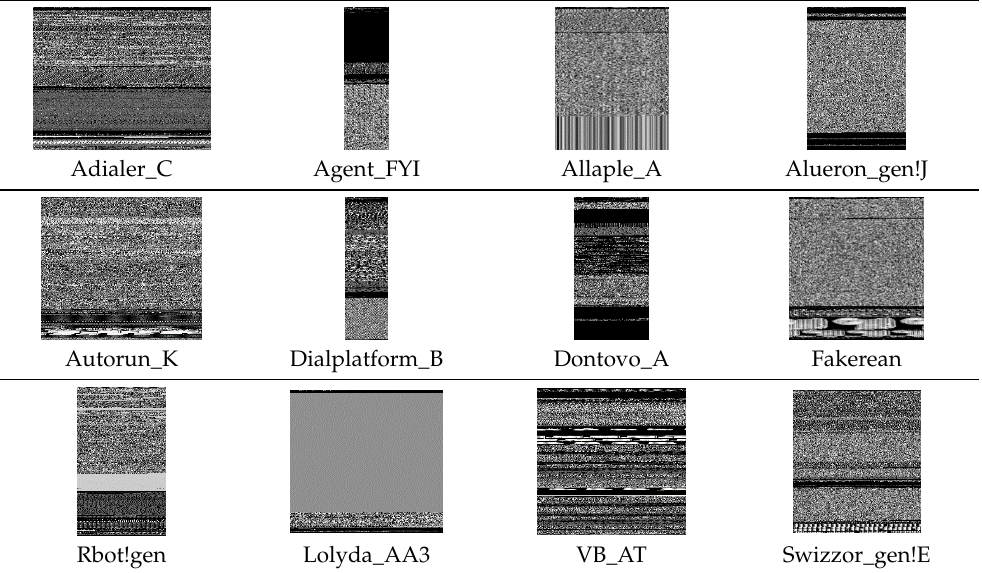
Table 2. Samples of 2D visualized malware images.